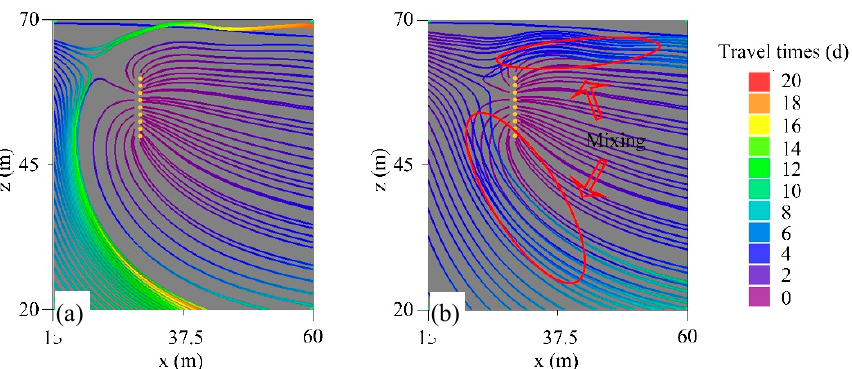
Figure 6. Simulated flow paths associated with travel times for ambient groundwater particles and artificially recharged water particles through the near-bank aquifer. ( a ) Scenarios with steady surface water levels. ( b ) Scenarios with a fluctuating surface water level, in which the T was set as 20 d and A was set as 5 m.